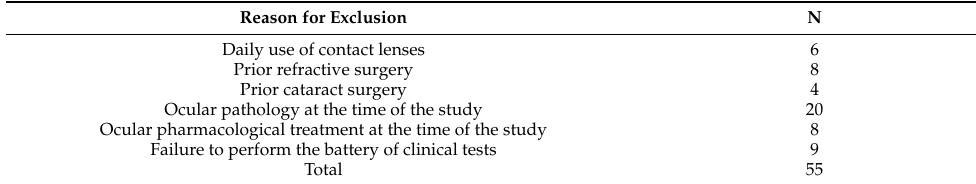
Table 1. Reasons for exclusion of the